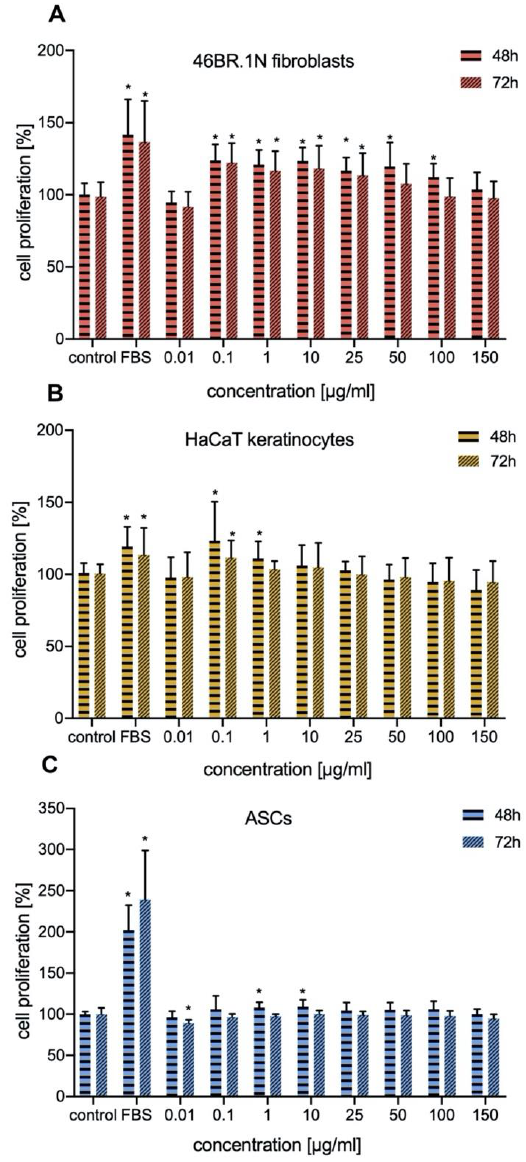
Figure 2. E ff ect of IM on proliferation of 46BR.1N fibroblasts ( A ) and HaCaT keratinocyte cell lines ( B ) and ( C ) adipose-derived stem cells (ASCs). The graph shows results from 4 independent experiments (4 replicates in each, n = 16). Results are presented as mean with SD. *—statistically significant di ff erences compared to control, Mann–Whitney U test, p < 0.05. FBS—positive control-cells grown in medium containing 10%